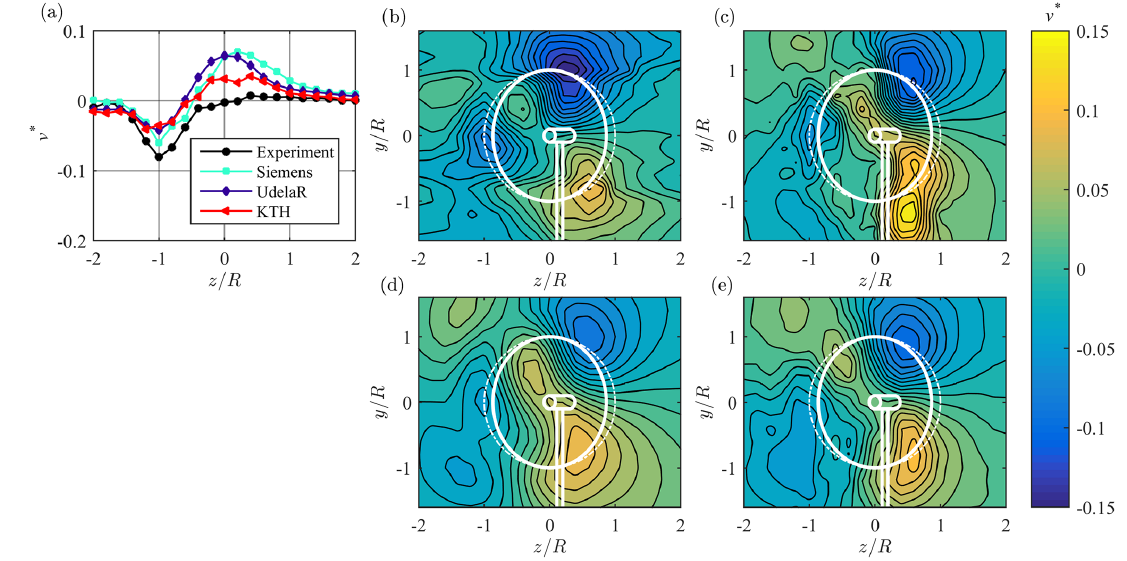
Figure 15. (a) Line plot at hub height and (b–e) contour plots for normalized vertical mean velocity v ∗ in the wake 3 D behind ForWind turbine, from (b) experiments, (c) Siemens, (d) UdelaR, and (e) KTH. The white lines represent the turbine rotor, nacelle, and tower; solid lines γ = 30 ◦ ; dashed lines γ = 0 ◦